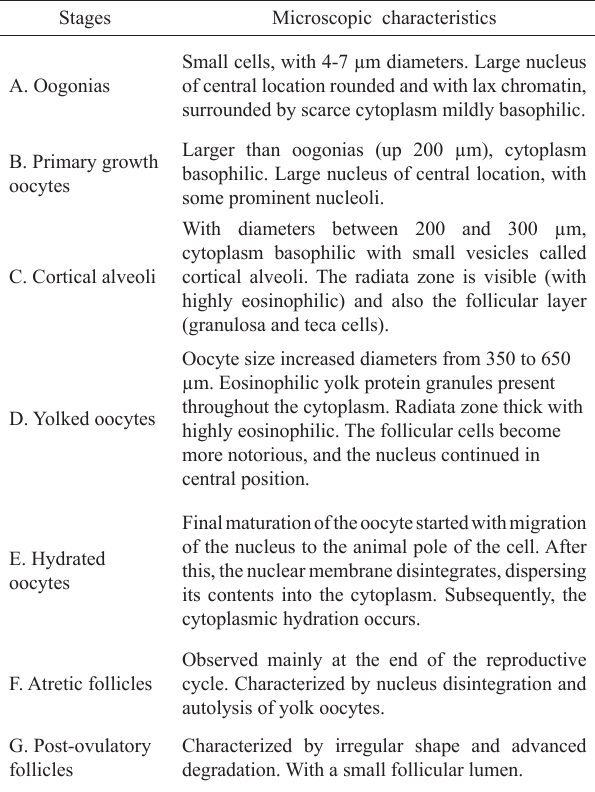
Table 1. Descriptions of stages of oocyte development, atretic follicles and post-ovulatory follicles.